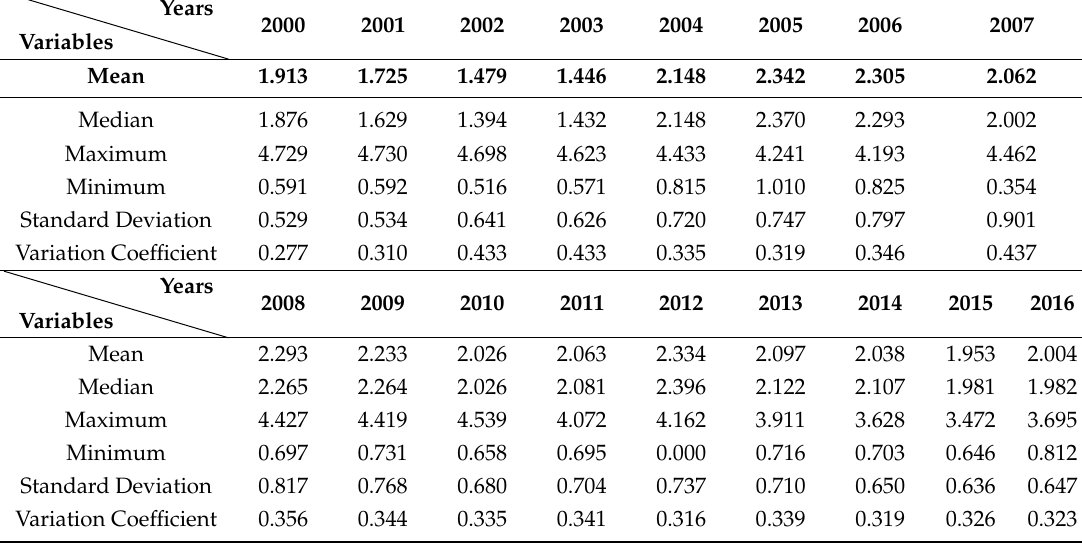
Table 4. Descriptive Statistical Analysis of Agricultural Land Use Intensity in Hubei Province from 2000 to